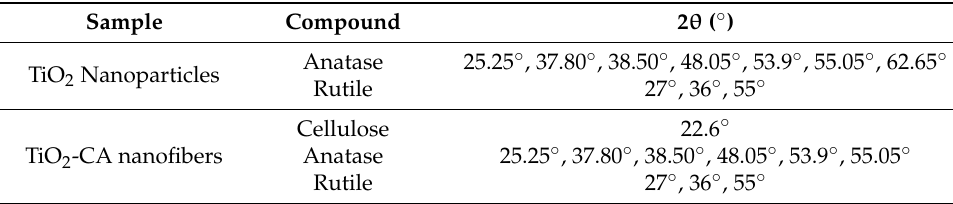
Table 2. XRD analysis of synthesized TiO 2 nanoparticles and TiO 2 -CA nanofibers.